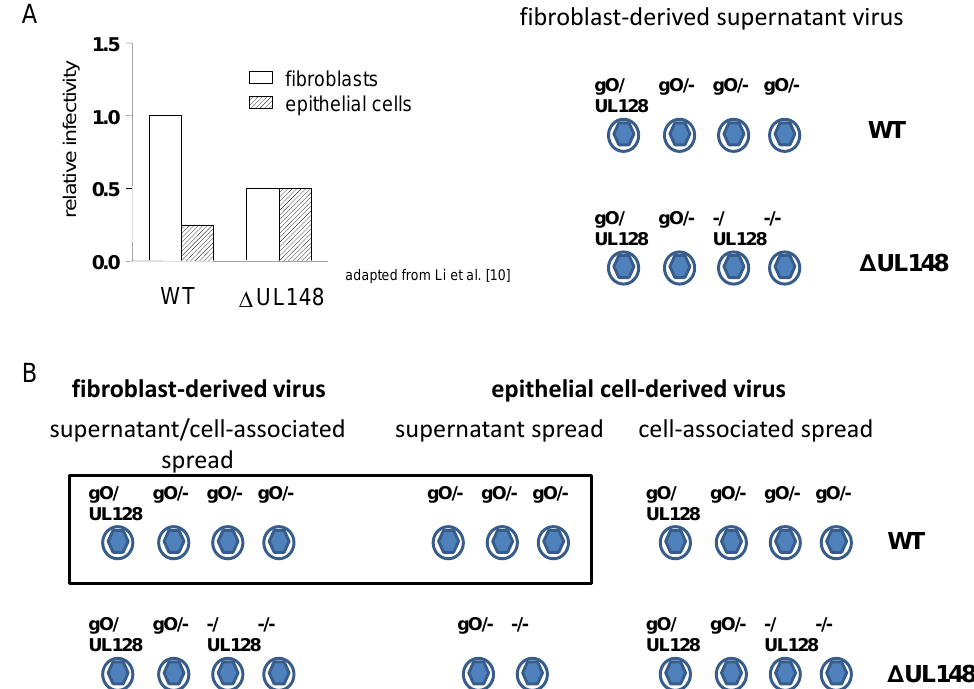
Figure 2. Model for a role of UL148 in shaping virus progenies. Based on differences in infection of fibroblasts and epithelial cells as described by Li et al. [10], a model of UL148-dependent shaping of virus progenies available for supernatant or cell-associated spread is proposed. Hypothetical and simplified virus progenies derived from fibroblasts infected with WT and ΔUL148 virus and the relative infectivities of these viral progenies are shown in ( A ); ( B ) shows a comparison of hypothetical virus progenies derived from fibroblasts and epithelial cells infected with WT or ΔUL148 virus. [gO/UL128] can infect fibroblasts and epithelial cells either cell-associated or via supernatant; [gO/−] can infect fibroblasts either cell-associated or via supernatant; [−/UL128] can infect fibroblasts and epithelial cells cell-associated, supernatant-driven infection of fibroblasts and epithelial cells is impaired; [−/−] not infectious.